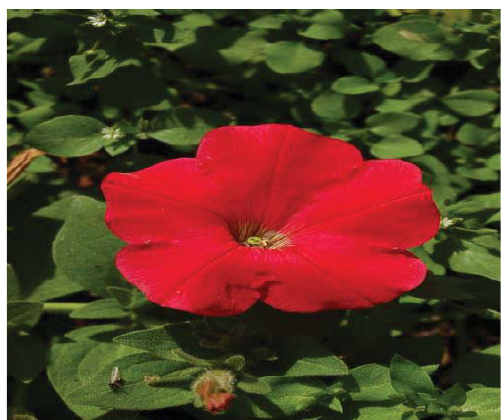
Fig. 7. Corresponding flower image i.e. for the above text description